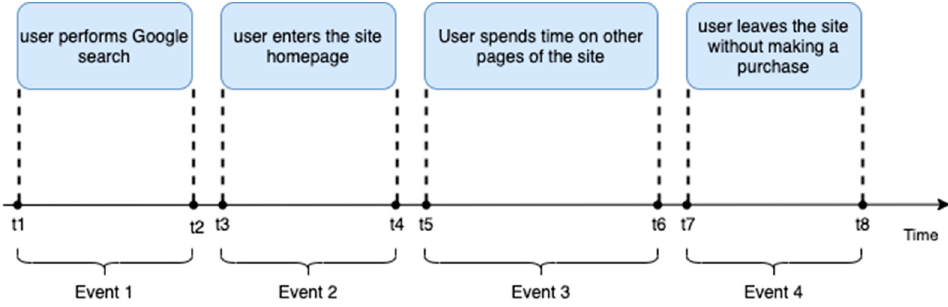
Figure 2. Consumer behavior as a sequence of events. Source: based on Thejaswini et al. [143].